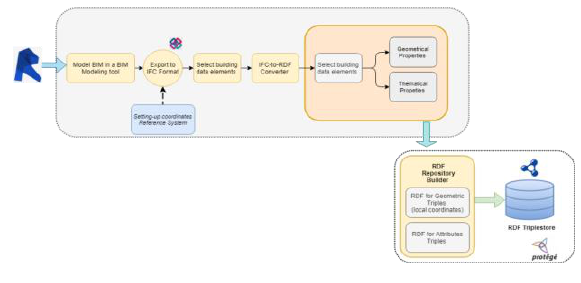
Figure 5 IFC to RDF translation workflow